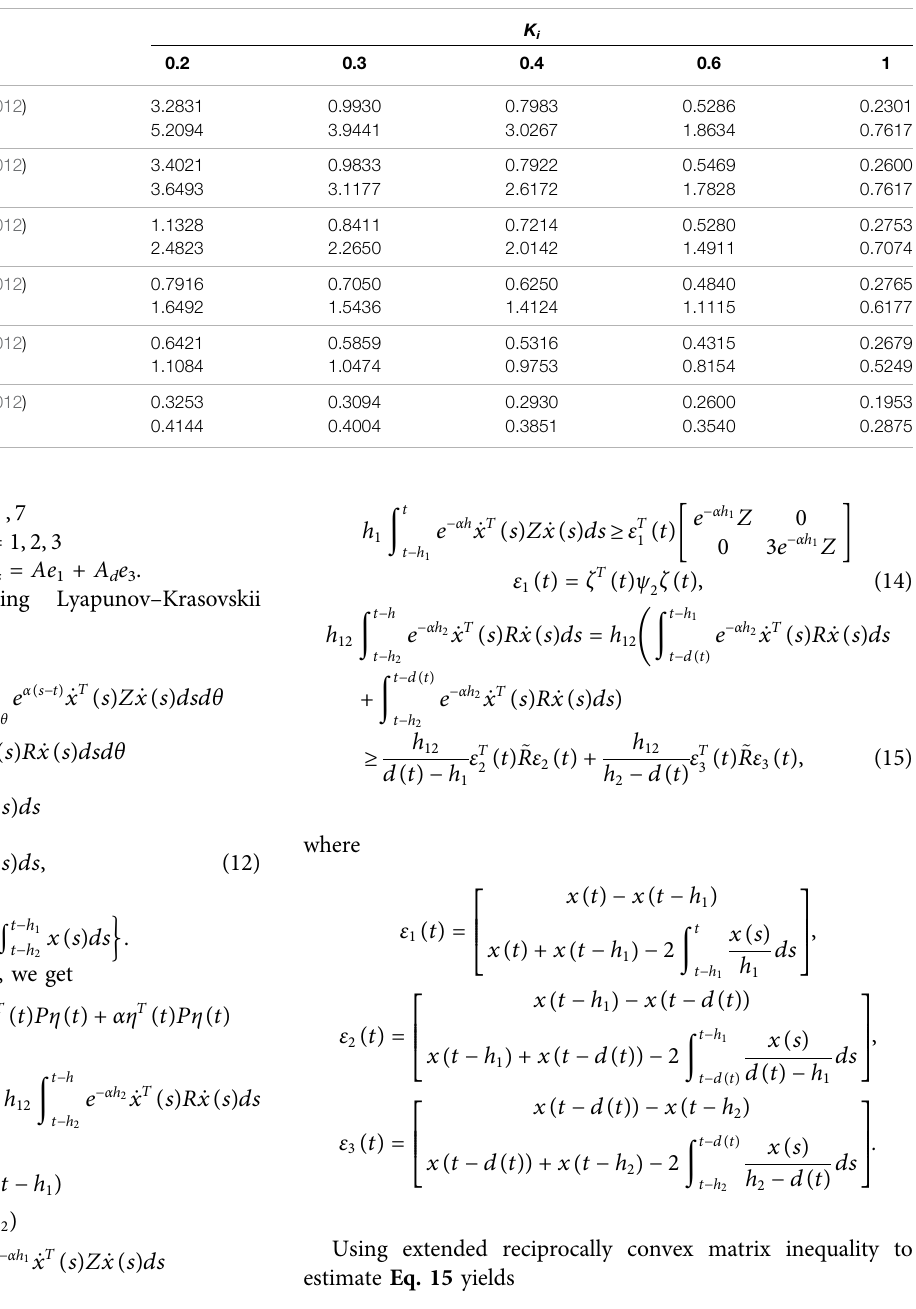
TABLE 2 | Delay margins for different